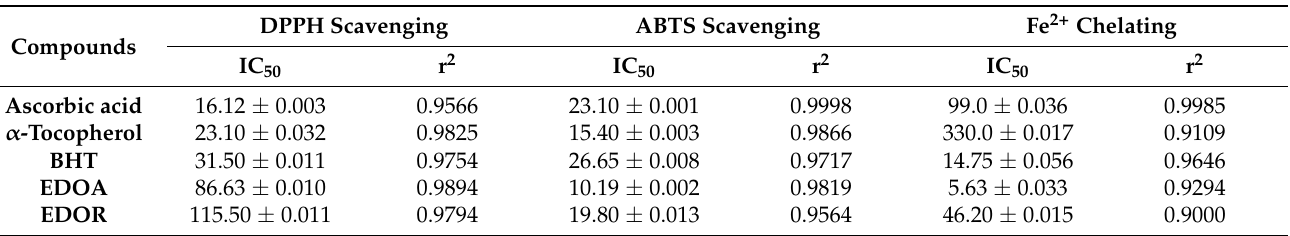
Table 1. The half maximal concentrations (IC 50 ; µ g/mL) for ethanol extract of aerial parts (EDOA) and roots (EDOR) of sahlep ( D. osmanica ) and